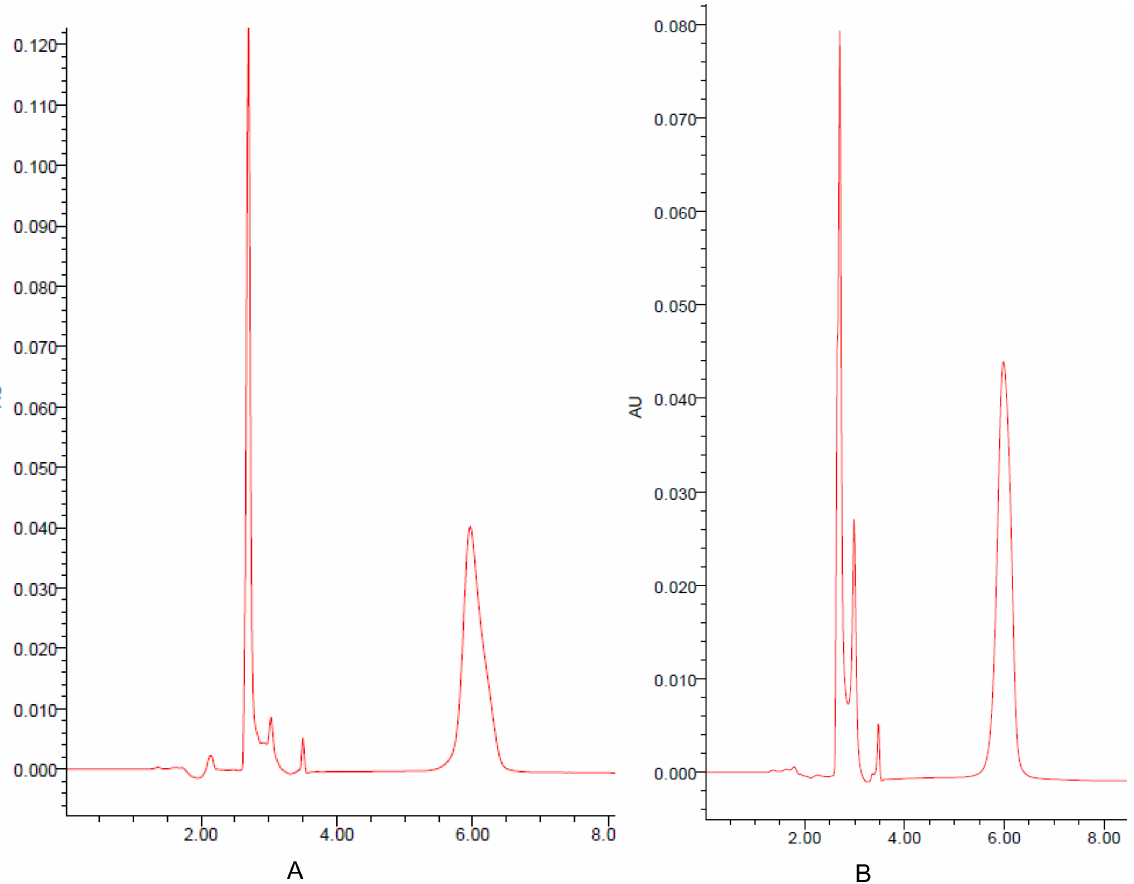
Fig 4. Determination by HPLC method. (A) Representative HPLC chromatogram of geniposide(5.967 min). (B) Chromatogram of geniposideof the optimizedformulations (5.990 min).